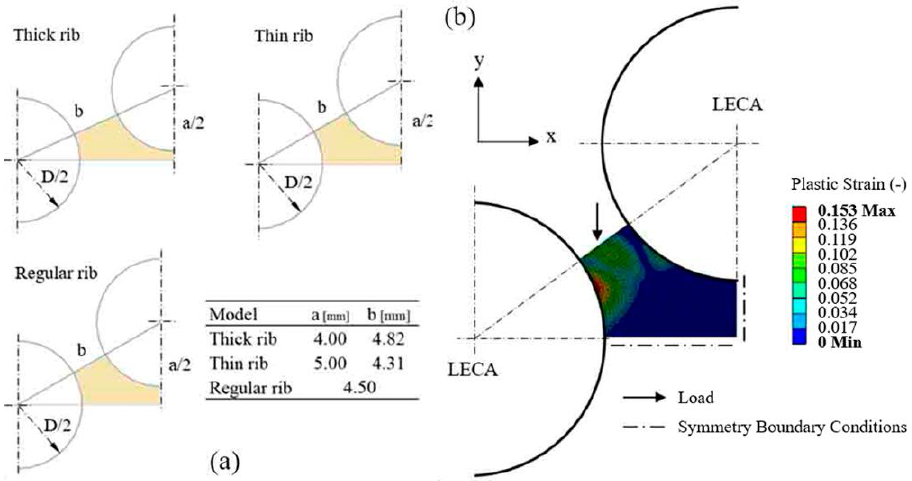
Figure 10. Representation of the simulation ( a ) models and ( b ) boundary conditions. Table 4. Finite element analysis (FEA) inputs details.